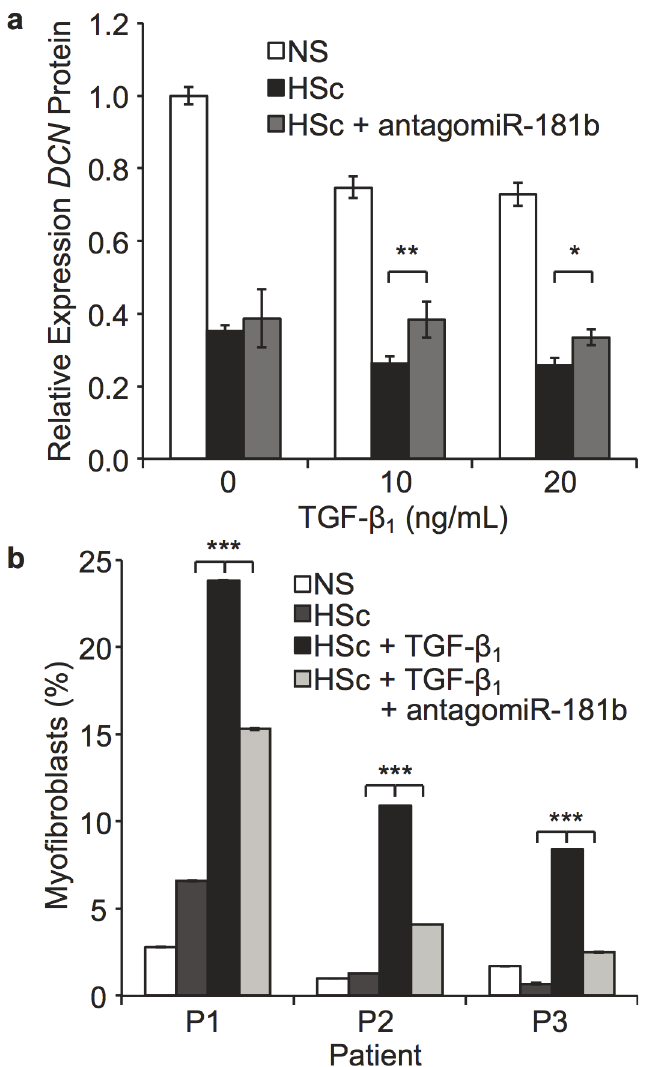
Fig 6. The effect of antagomiR-181b on TGF- β 1 stimulated NS and HSc fibroblasts. (a) antagomiR-181b reversed DCN downregulation in HSc fibroblasts. Cells were stimulated by TGF- β 1 at indicated concentrations and transfected with antagomiR-control or antagomiR-181b for 48 hours in DMEM + 2% FBS, and DCN protein was measured using ELISA on the supernatants (mean ± SEM, n = 3, * P < 0.02, ** P < 0.006). (b) antagomiR-181b reversed myofibroblast differentiation in HSc fibroblasts. Cells were stimulated by TGF- β 1 10 ng/mL and transfected with antagomiR-control or antagomiR-181b for 48 hours in DMEM + 2% FBS then permeabilized and stained for α -smooth muscle actin and 10 000 cells per sample measured by flow cytometry (mean ± SEM, n = 3, *** P <